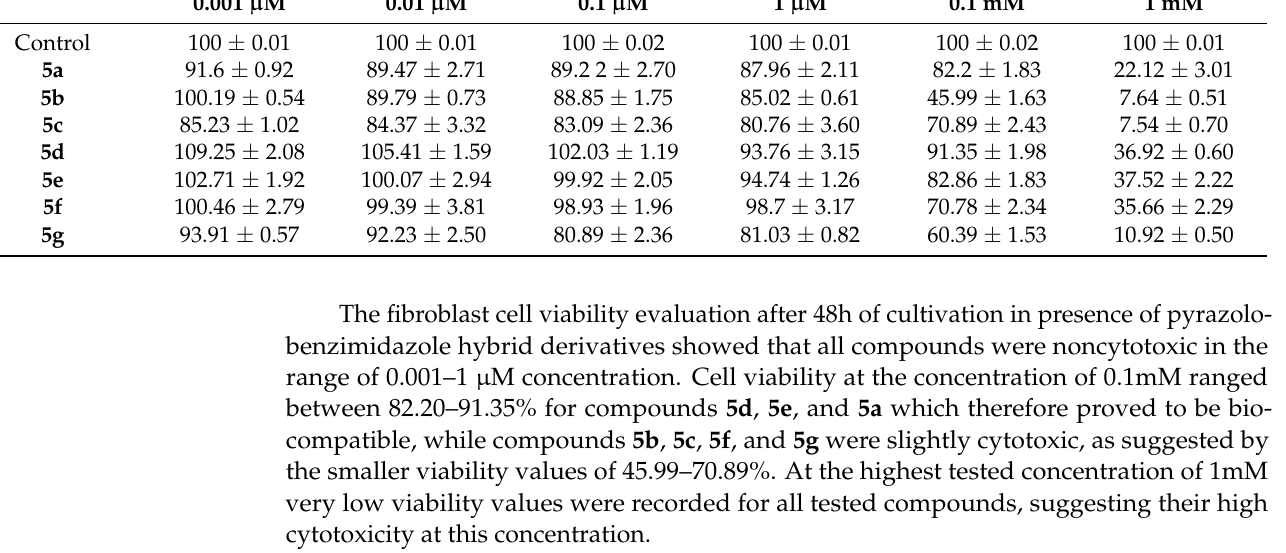
Table 1. Cell viability evaluated by MTT assay at 48h of treatment. Comp.